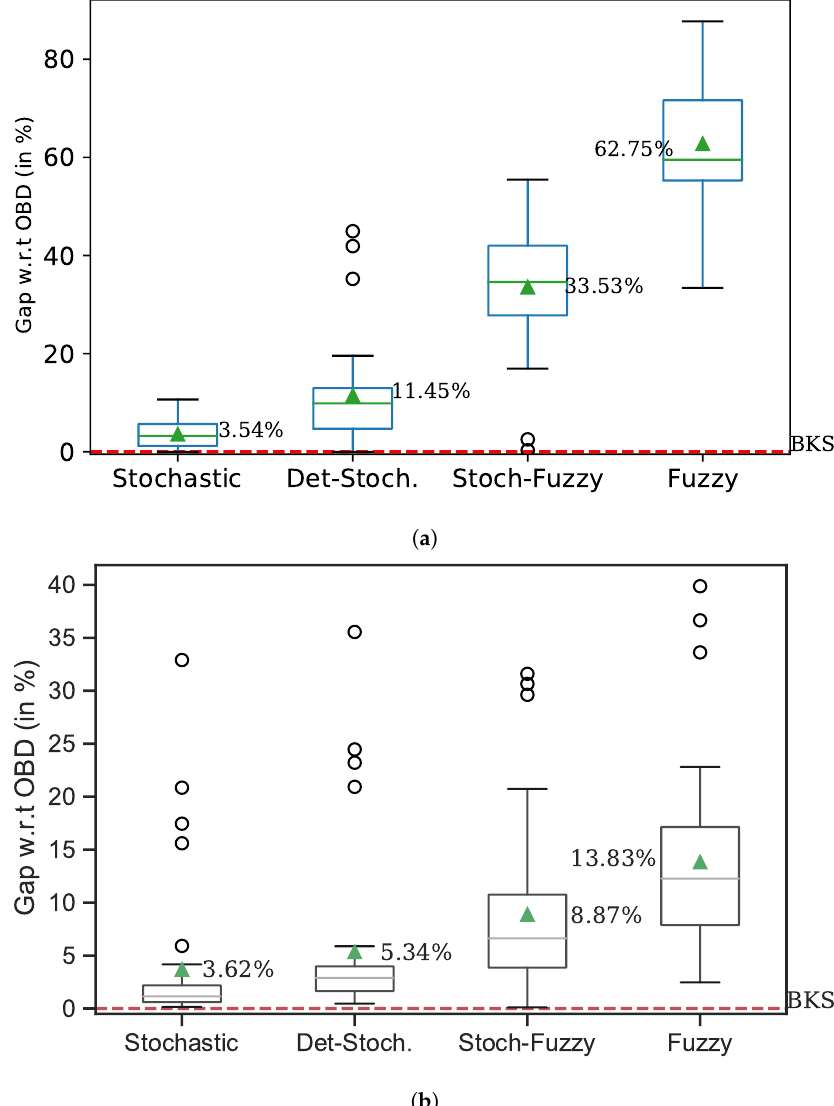
Figure 8. Gaps of different optimization methods with respect to the OBD solution. ( a ) Results for the VRP dataset. ( b ) Results for the TOP dataset.